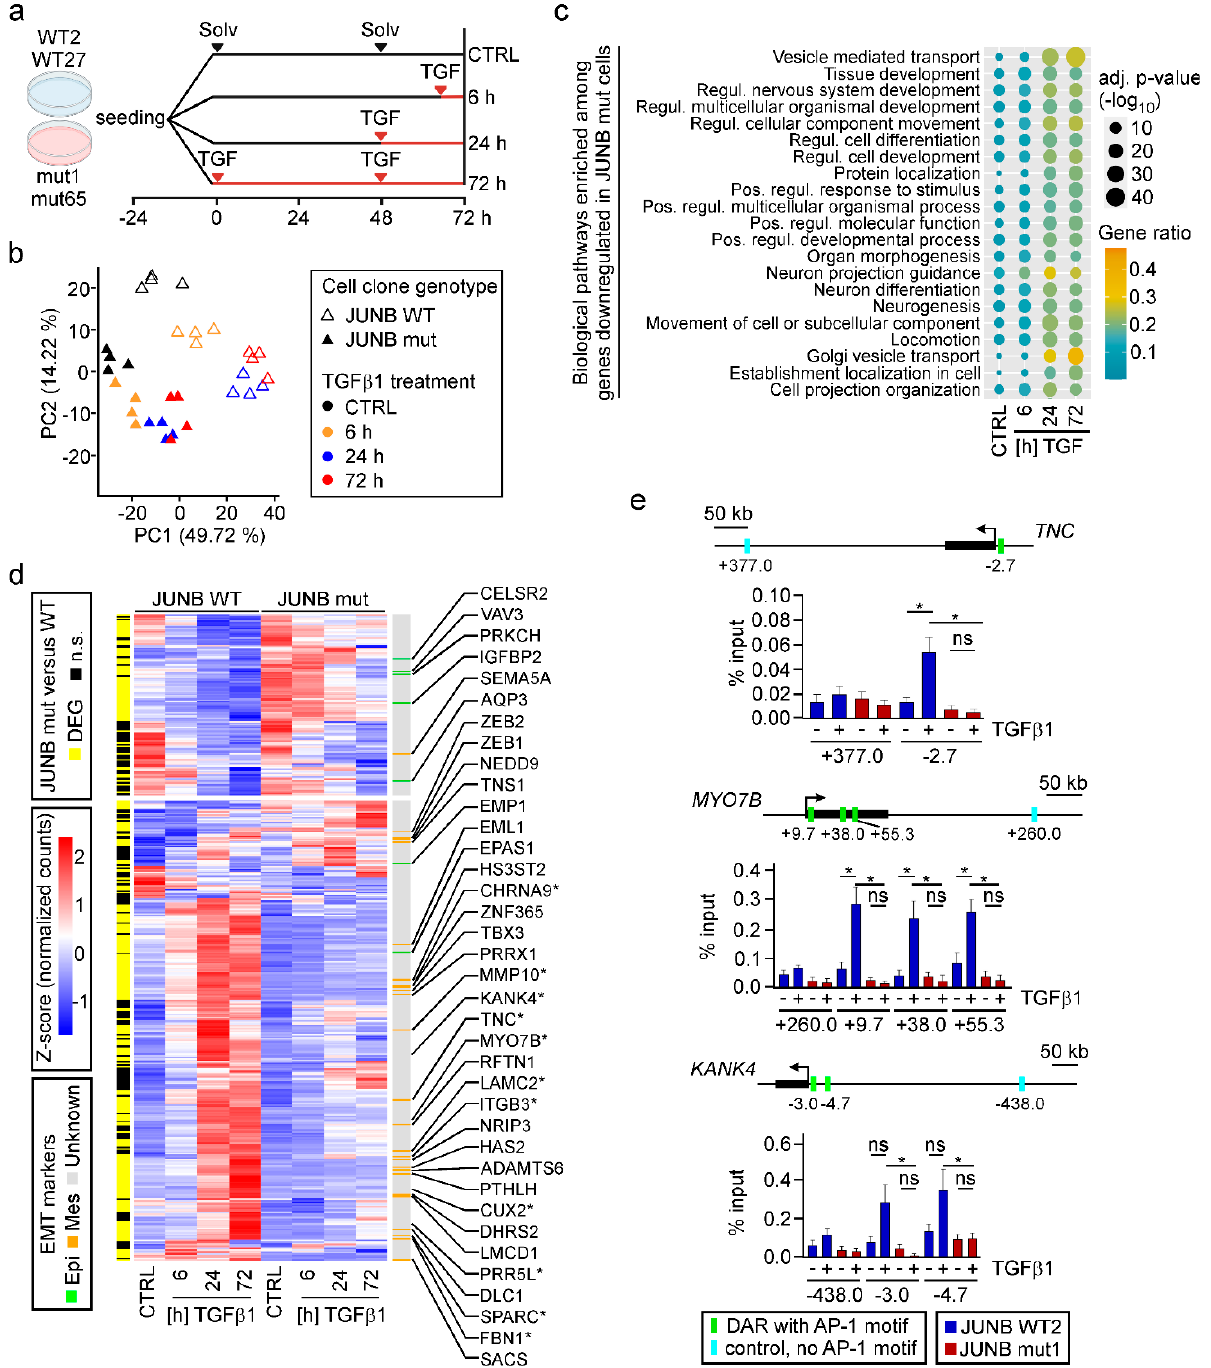
Figure 7. JUNB loss-of-function impairs TGF β 1-induced transcriptional reprogramming. ( a ) Experimental setup for the RNA-seq time course experiment of MCF10A JUNB WT and mut clones. Each JUNB clone was seeded in four different plates and treated with 5 ng/mL TGF β 1 (TGF) for the times indicated. Control (CTRL) samples were treated with solvent (Solv) solution for 72 h. All samples were harvested and processed for RNA isolation three days after seeding. ( b ) PCA of RNA-seq data from MCF10A JUNB WT and mut clones treated with solvent or TGF β 1 as described in ( a ). For each condition, two independent biological replicates are analyzed. ( c ) Enrichment analysis of GO terms “Biological Processes” for DEGs showing reduced responses to TGF β 1 in MCF10A JUNB mutant